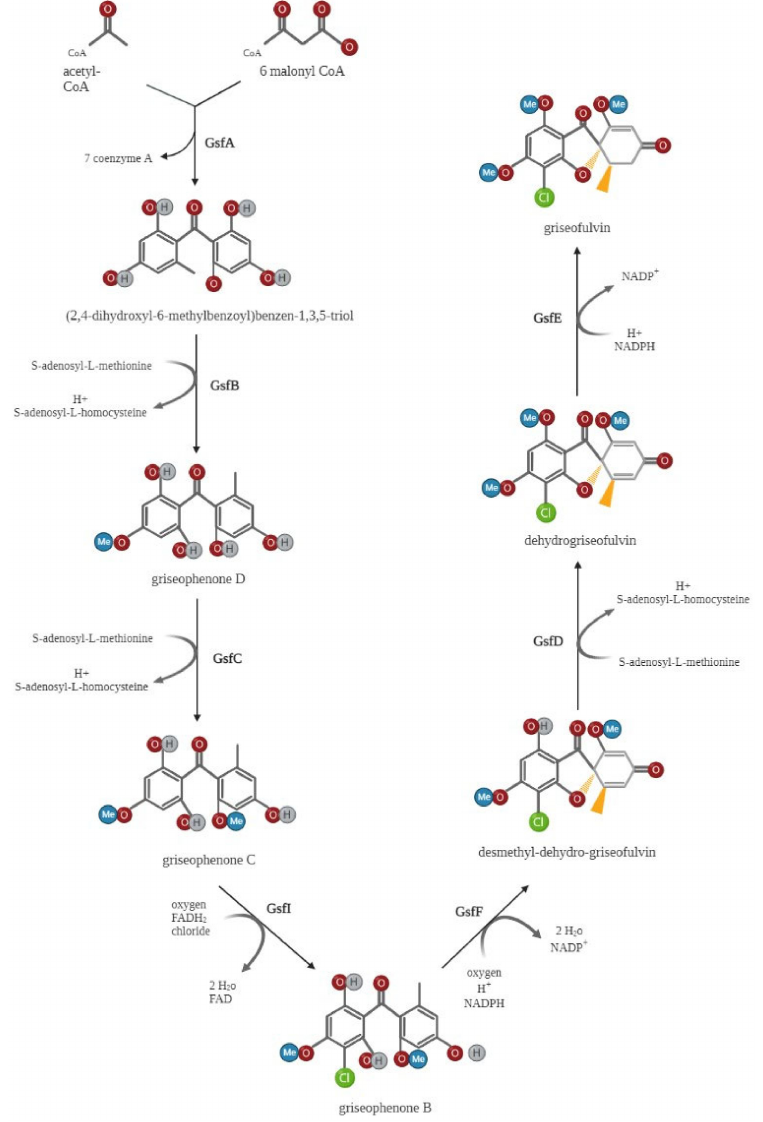
Figure 2. Griseofulvin biosynthetic pathway. The nonreducing polyketide synthase gsfA